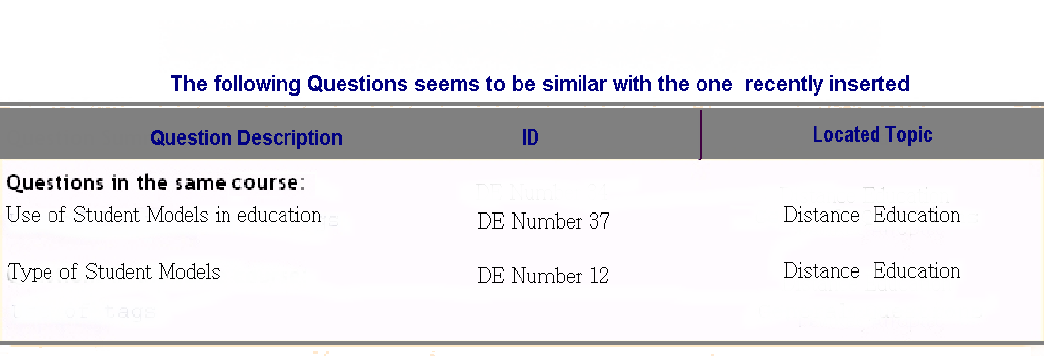
Figure 3. Potential similar